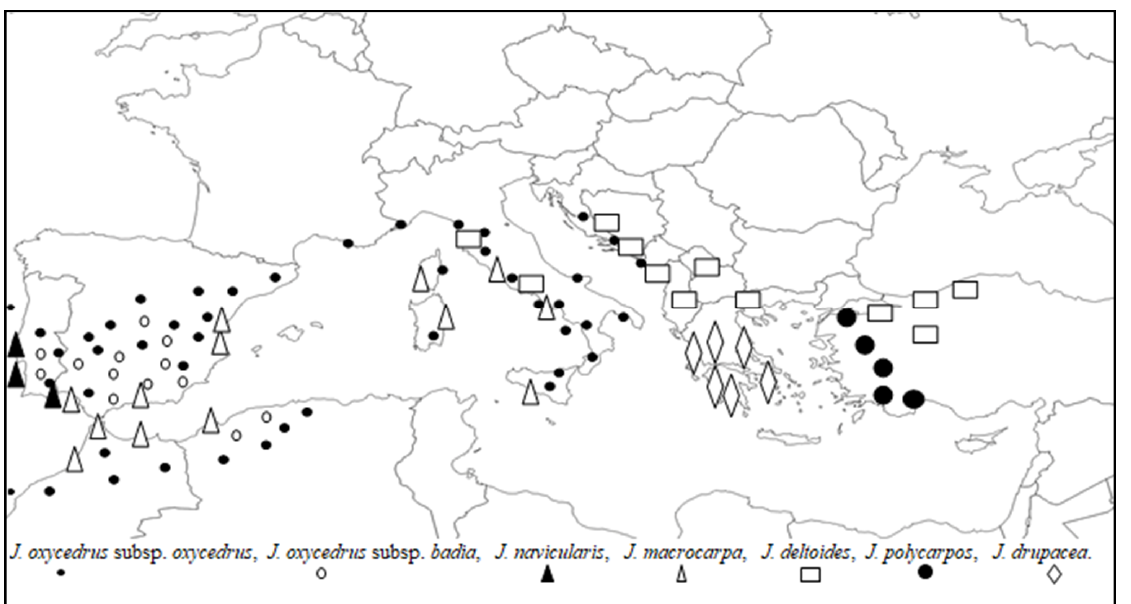
Figure 4. Distribution of the Juniperus oxycedrus group in the Mediterranean basin: Coexistence of populations of J. oxycedrus subsp. oxycedrus and subsp. badia in the Iberian Peninsula. The areas dominated by the species of juniper are currently undergoing a process of